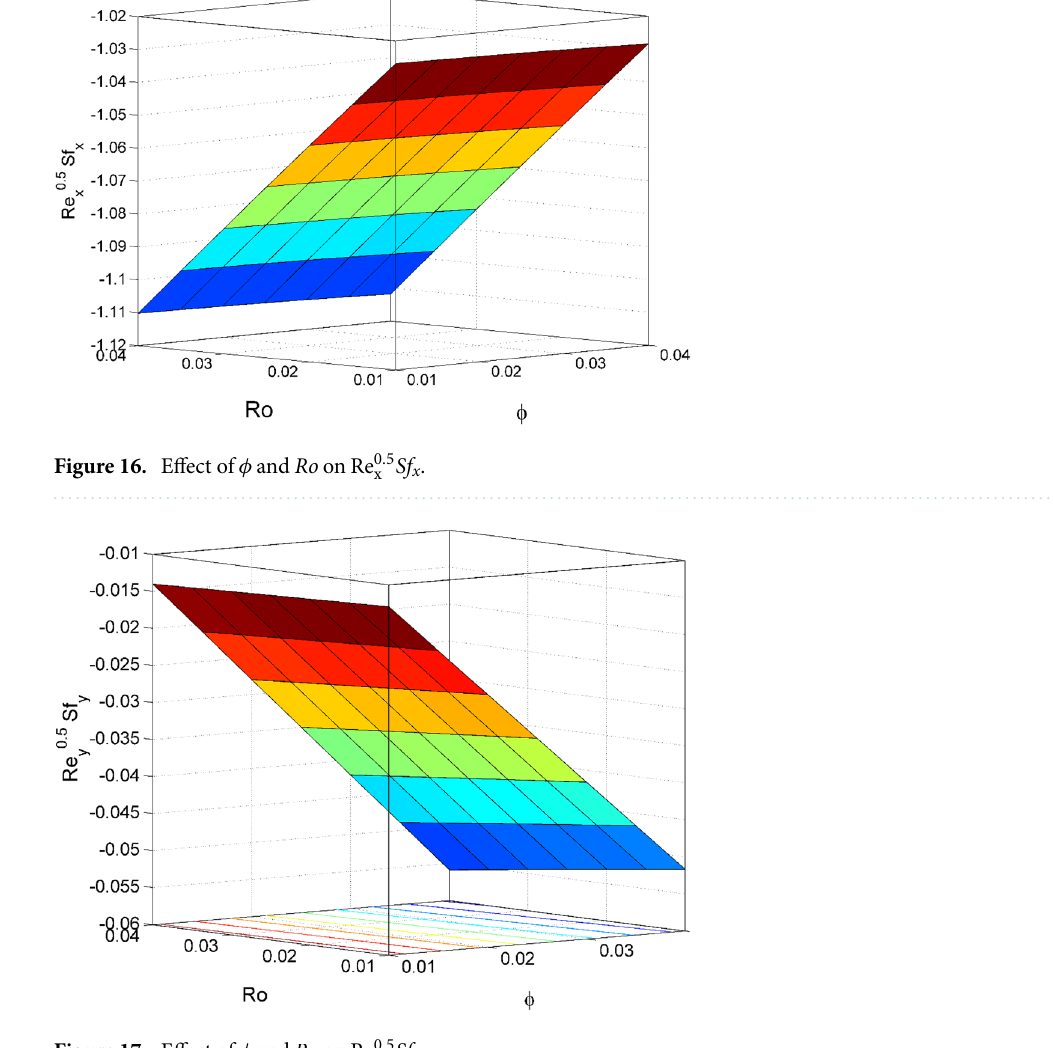
Figure 17. Effect of φ and Ro on Re 0.5 y Sf y